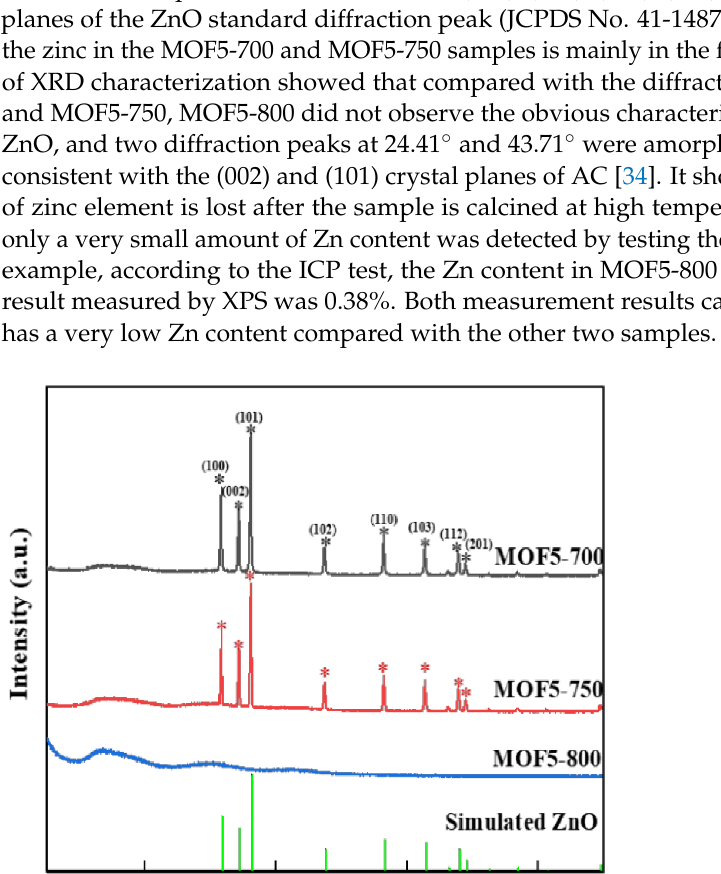
Figure 13. X RD spectra of MOF5-700, MOF5-750 and MOF5-800 . Figure 13. XRD spectra of MOF5-700, MOF5-750 and